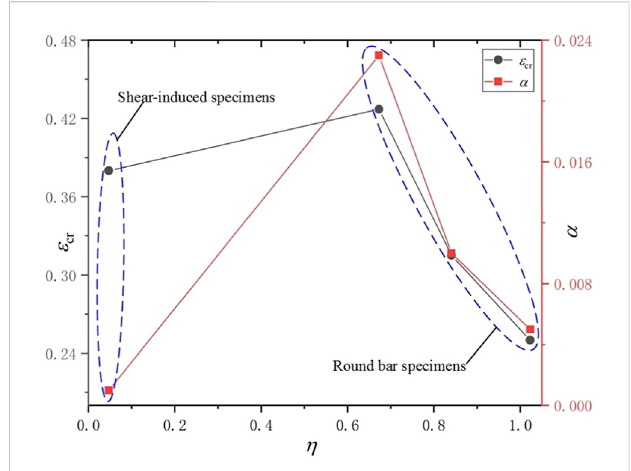
FIGURE 8 Stress triaxiality versus damage parameters.